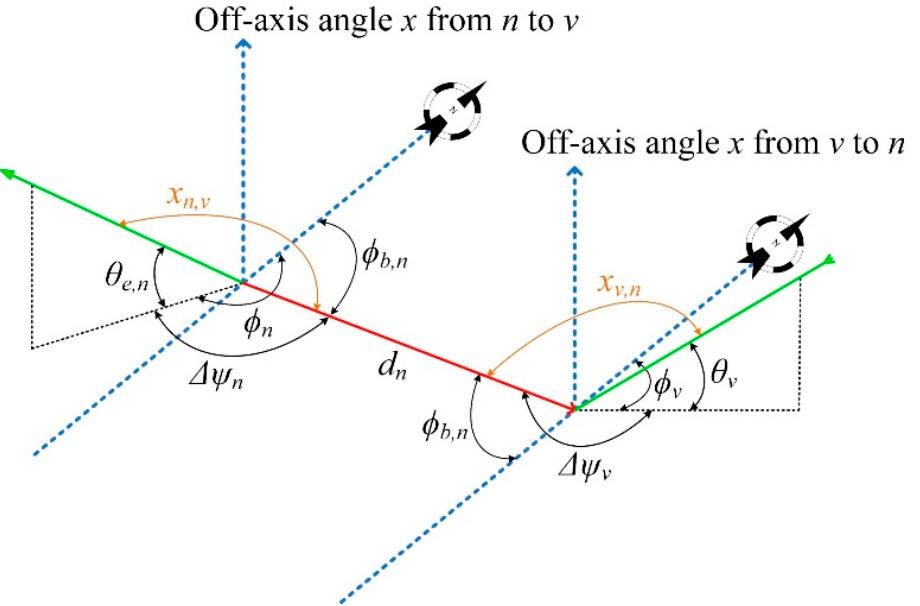
Figure 2. Three-dimensional geometry to define the off bore-sight angle between an interfering and victim station.